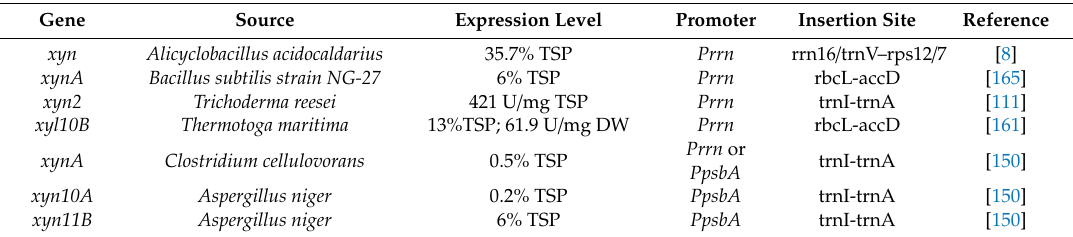
Table 7. Xylanse produced by tobacco